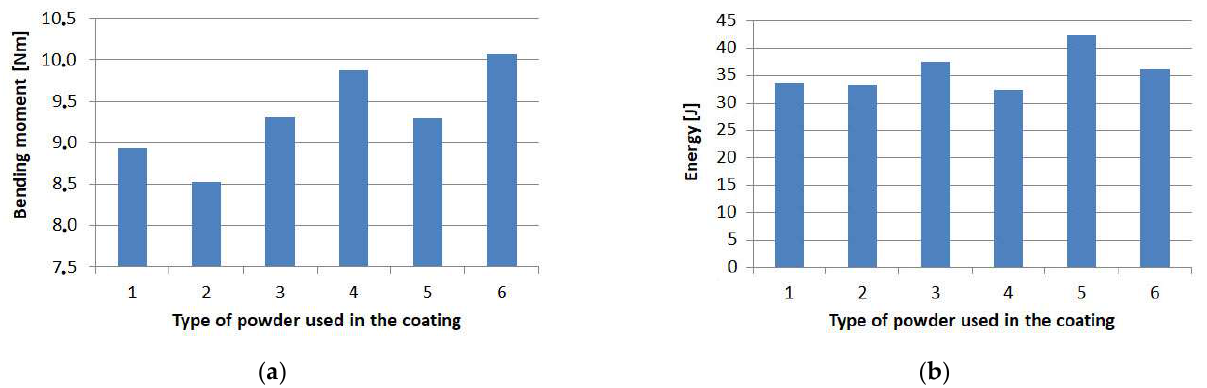
Figure 17. Results of experiments: ( a ) averaged maximum bending moment values; and ( b ) averaged energy values.